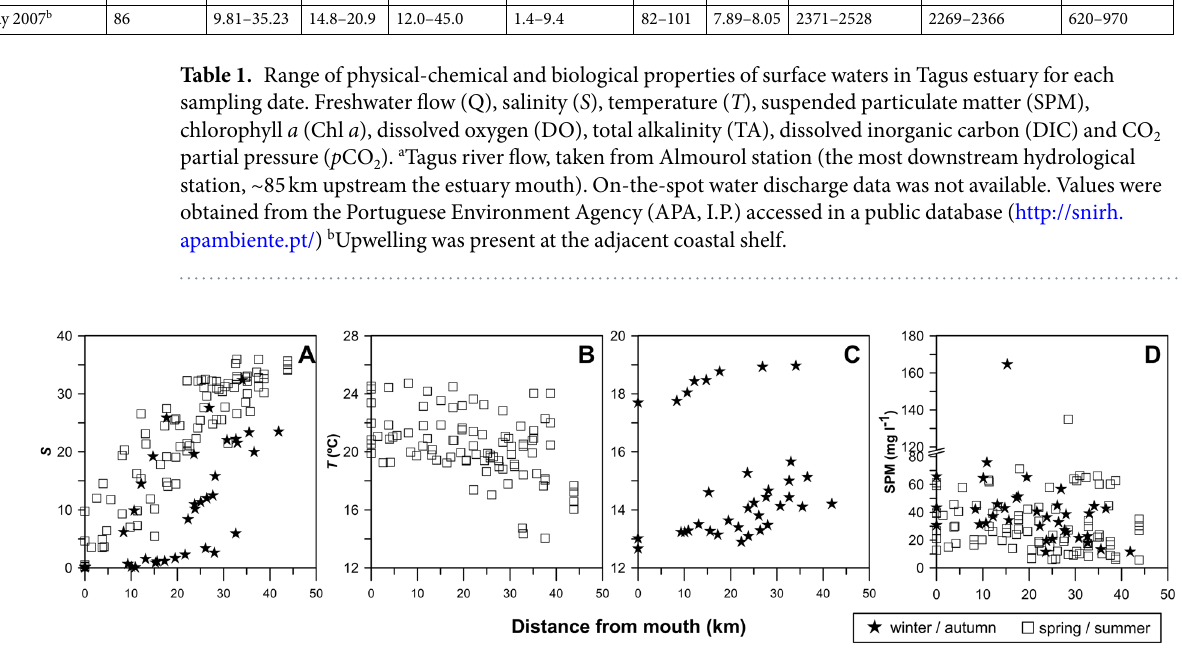
Figure 2. Longitudinal distributions of ( A ) salinity ( S ), ( B ) temperature ( T ) in spring/summer, ( C ) temperature ( T ) in winter/autumn and ( D ) suspended particulate matter (SPM), during the 10 surveys carried out along Tagus estuary. Riverine end-member: sampling station with lowest salinity; Marine end-member: sampling station nearest the